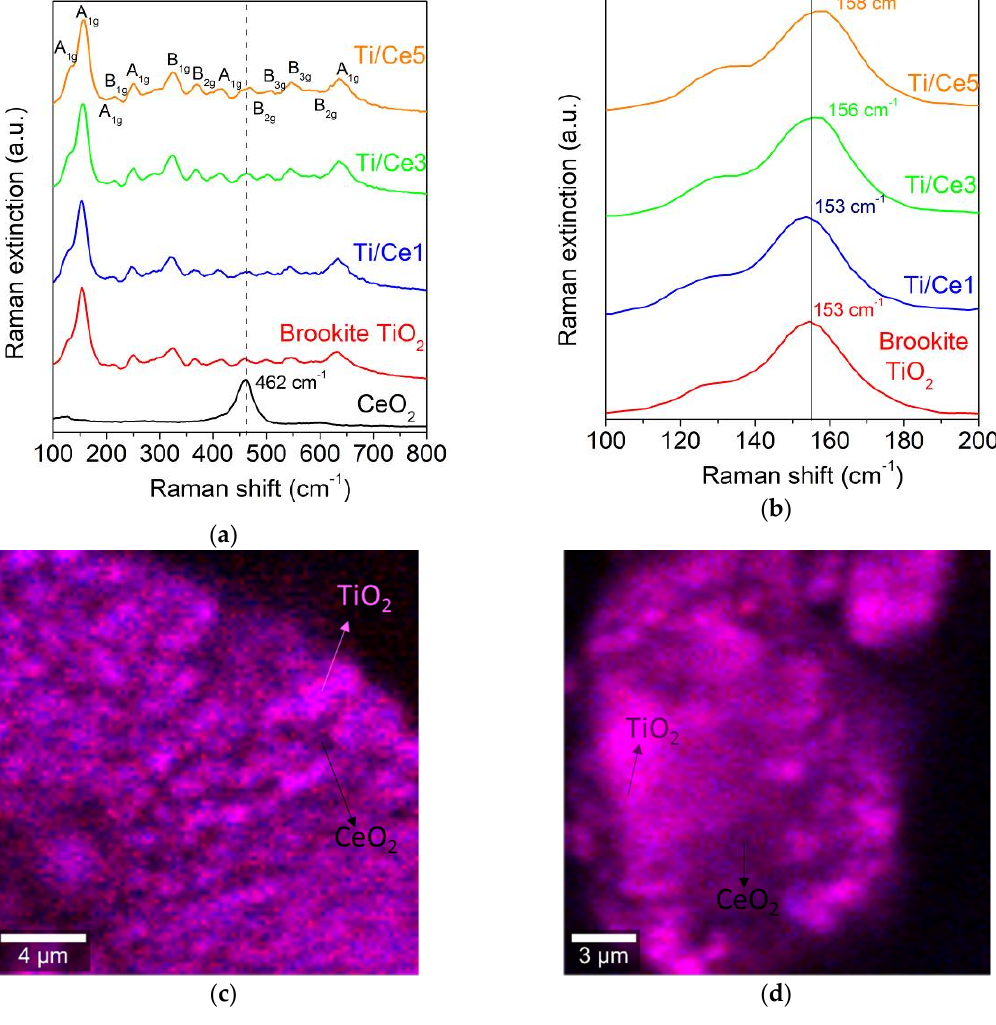
Figure 1. ( a ) Raman spectra of the analyzed samples; ( b ) Raman shift of the main brookite band; ( c ) Raman confocal map of the Ti/Ce3 sample; and ( d ) Raman confocal map of the Ti/Ce5 sample.